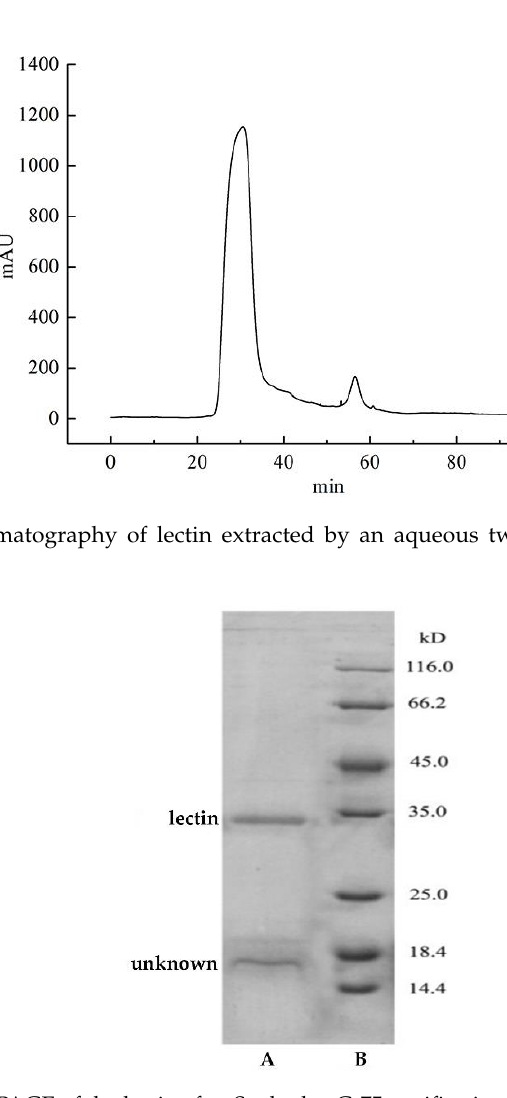
Figure 2. SDS-PAGE of the lectin after Sephadex G-75 purification: A , sample; B , marker.